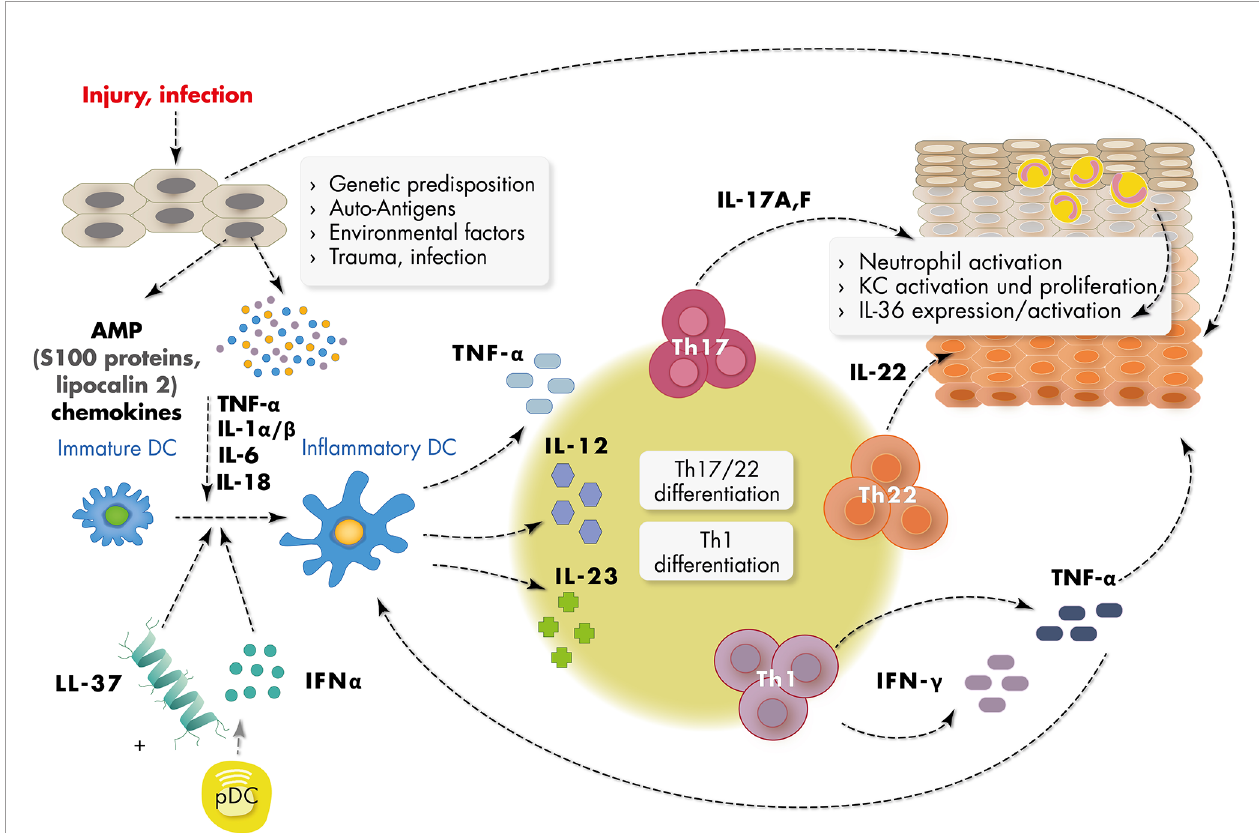
FIGURE 1 | Schematic representation of major in fl ammatory mediators in psoriasis pathogenesis. Epidermal keratinocytes (KC) in psoriasis are targeted by multiple triggers of the environment such as infection, trauma, traction forces and chemicals and are subsequently activated to produce short nucleotides and antimicrobial peptides (AMPs) such as LL37 and S100 proteins, and chemokines. Activated dermal plasmacytoid dendritic cells (pDC) produce IFN- a in the context of a number of other cytokines such as IFN- g , TNF- a , and IL-1 a / b , which leads to activation of myeloid (in fl ammatory) dendritic cells. Activated dendritic cells produce cytokines such as IL-23 inducing Th1 and Th17 and Th22 differentiation of T cells. IL-17, IL-22 and IFN- g produced by these cells further activate keratinocytes. Activated keratinocytes show high proliferation rates and disturbed differentiation leading to epidermal acanthosis and support the in fl ammatory